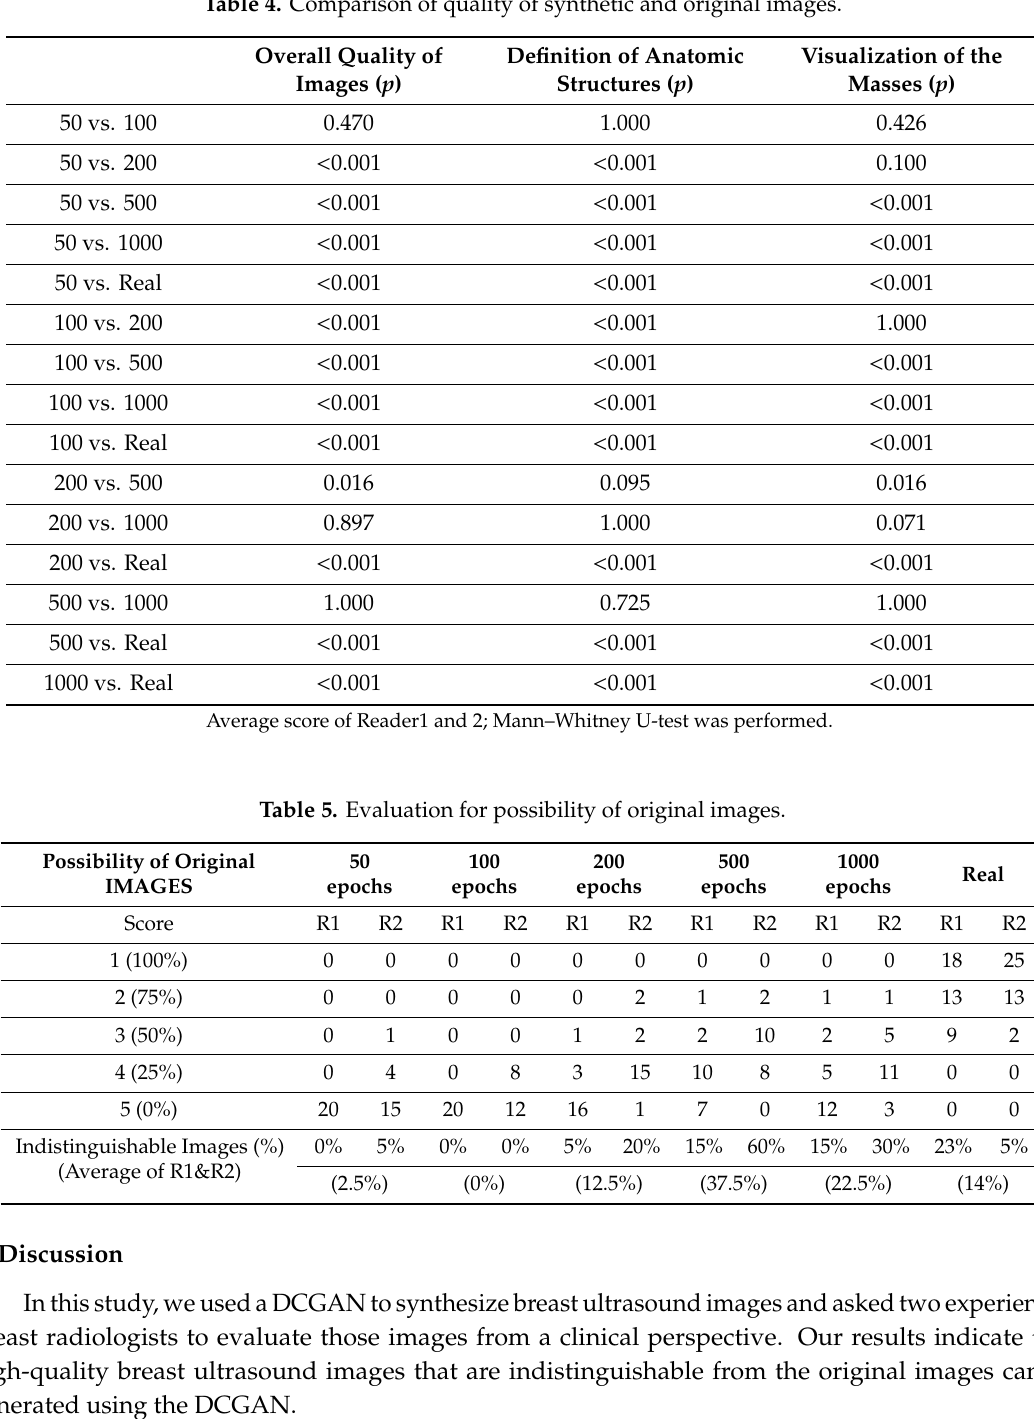
Table 4. Comparison of quality of synthetic and original images.